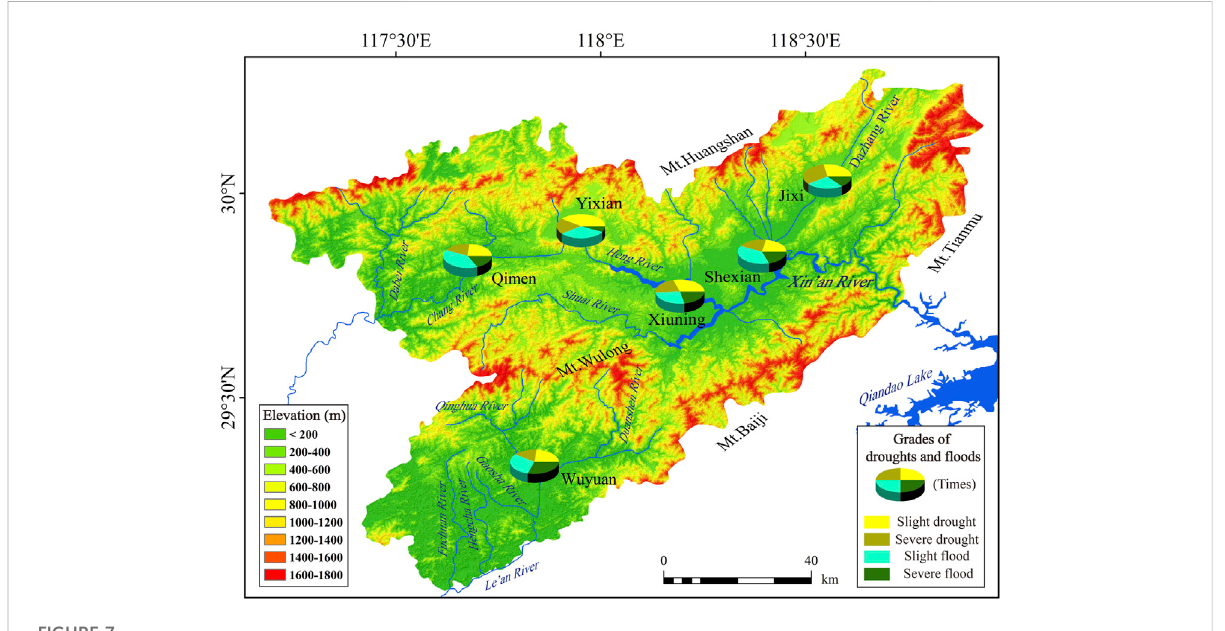
FIGURE 7 Spatial distributions of different grades of fl oods and droughts in the counties.